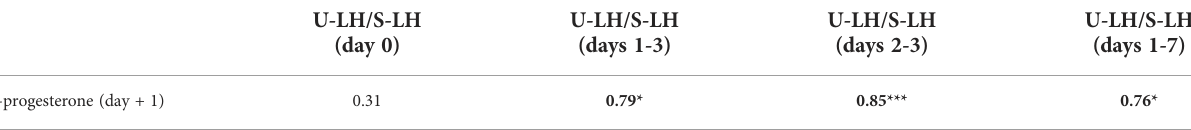
TABLE 2 Correlation of serum progesterone levels on the day after LH peak with the the ratio of total luteinizing hormone immunoreactivity (LH-ir) in urine to intact LH-ir in serum (representing the nonintact LH-ir in urine) during the fi rst week after LH